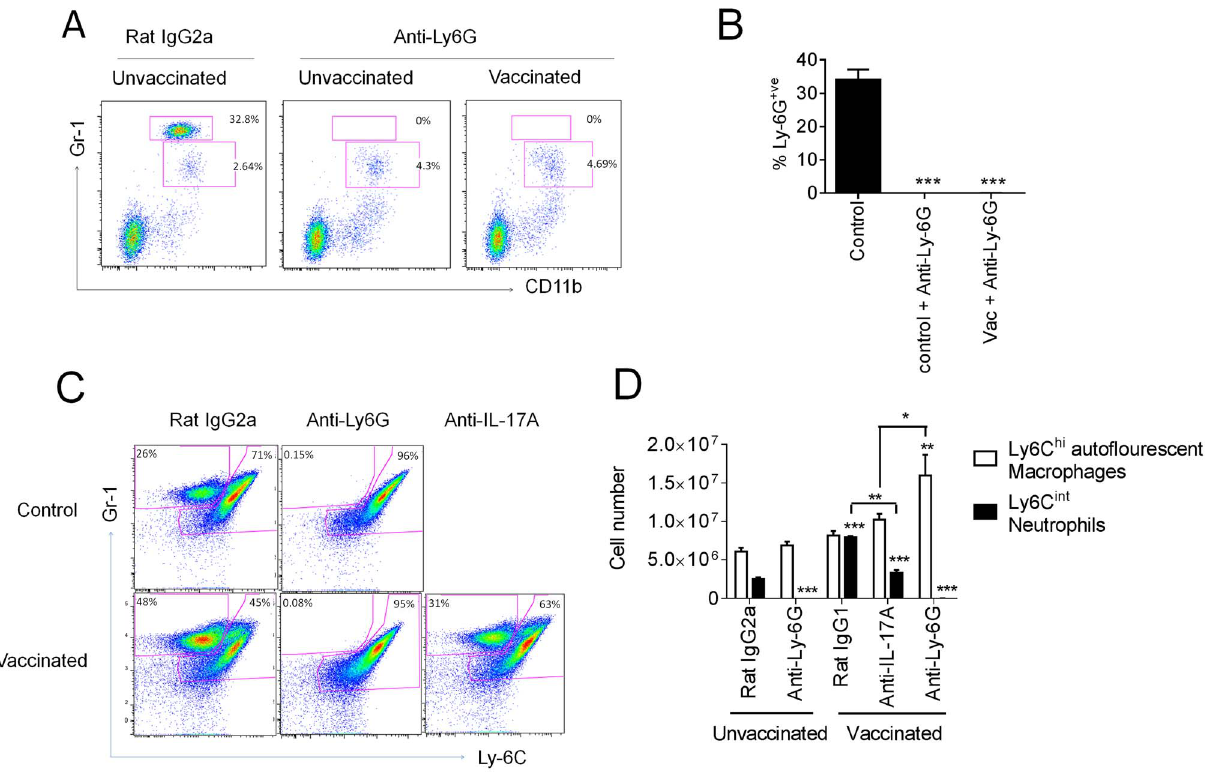
Figure 5. IL-17A neutralization reduces augmented neutrophil response. Mice vaccinated intranasally with split influenza virus antigen (A/ Uruguay/716/2007 (H3N2)) and CRX-601 were administered with anti-Ly-6G or anti-IL-17A (100 m g) i.p. one day prior to challenge with influenza virus and then daily for a further 6 days post challenge. Neutrophil depletion efficiency was monitored in peripheral blood 24 h post antibody treatment (A,B). Confirmation of neutrophil depletion (C) as well as enumeration of Gr-1 + subsets (D) was examined in the lung 5 days post infection. Data in B and D are means 6 SEM for three biological replicates and is representative of two independent experiments. * p , 0.05, ** p , 0.01, ***p , 0.001, are significantly different from control, Rat IgG2a (One-way ANOVA, Dunnet